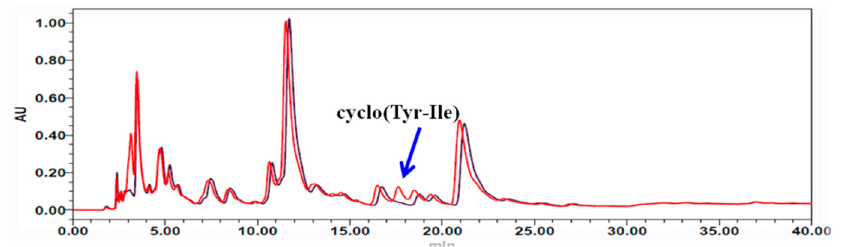
Figure 6. Comparison of QS signaling molecule synthesis between a wild-type S. odorifera strain and its mutant. Wild-type S. odorifera (red); S. odorifera mutant (black).